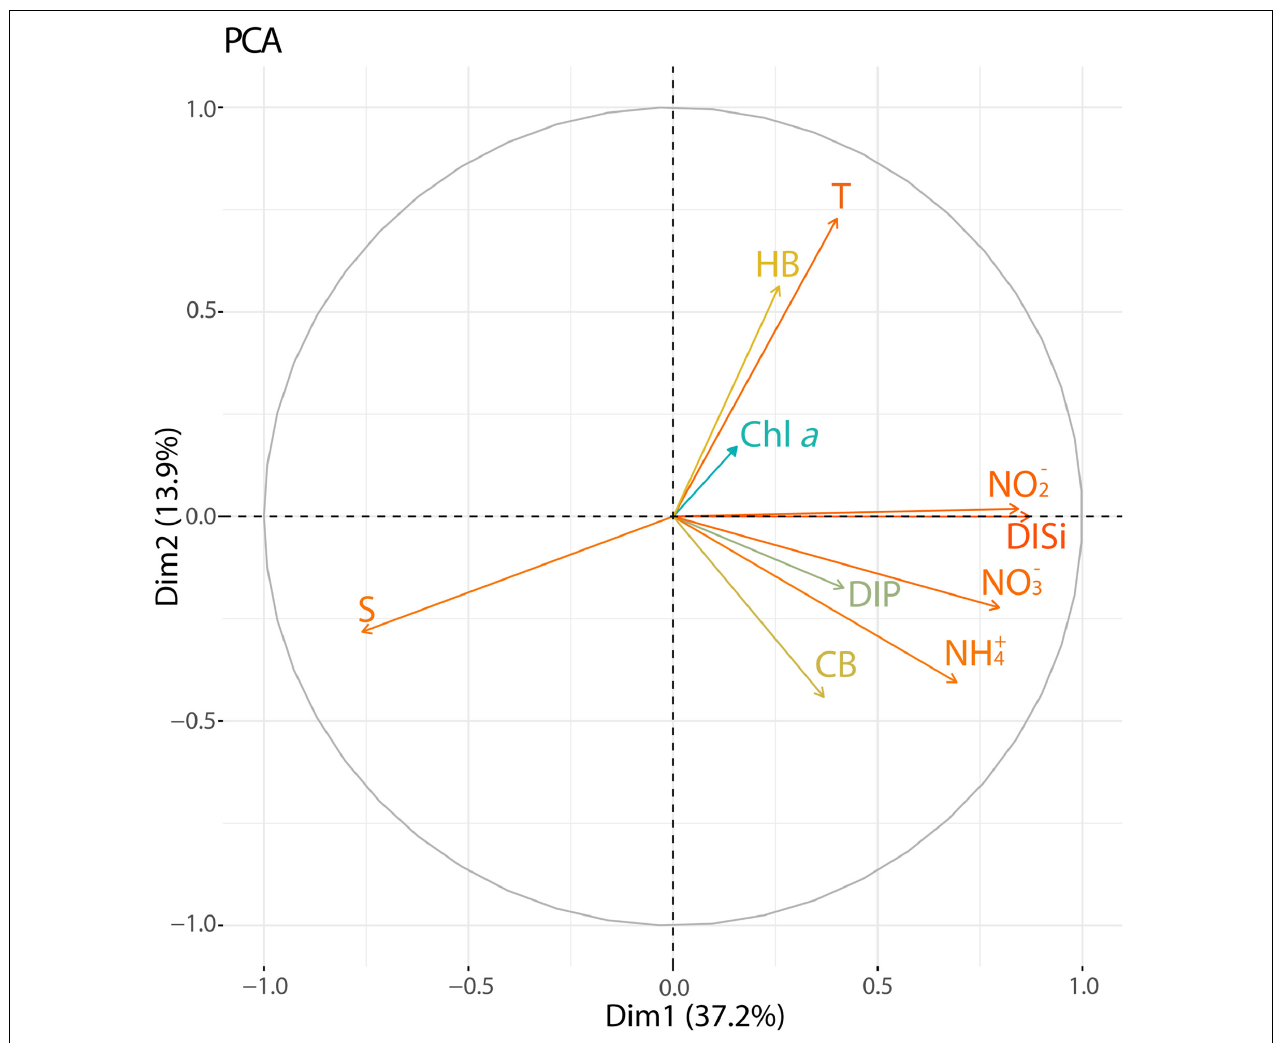
FIGURE 7 | Principal component analysis of CB abundance and environmental